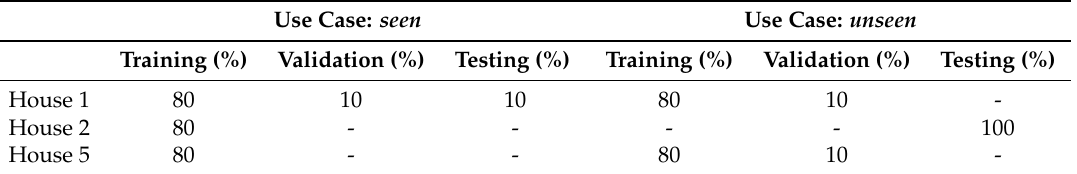
Table 3. Training, Validation and Testing dataset composition for the seen and unseen use cases. Use Case: